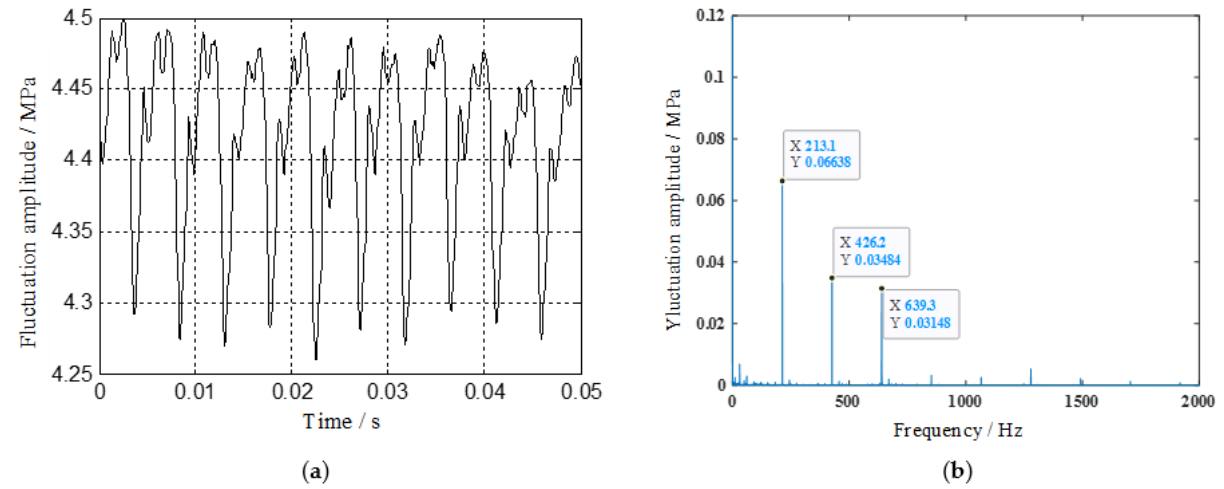
Figure 12. Load pressure ( p 1 = 4.375 MPa) waveform. ( a ) Time domain diagram; ( b ) frequency domain map.